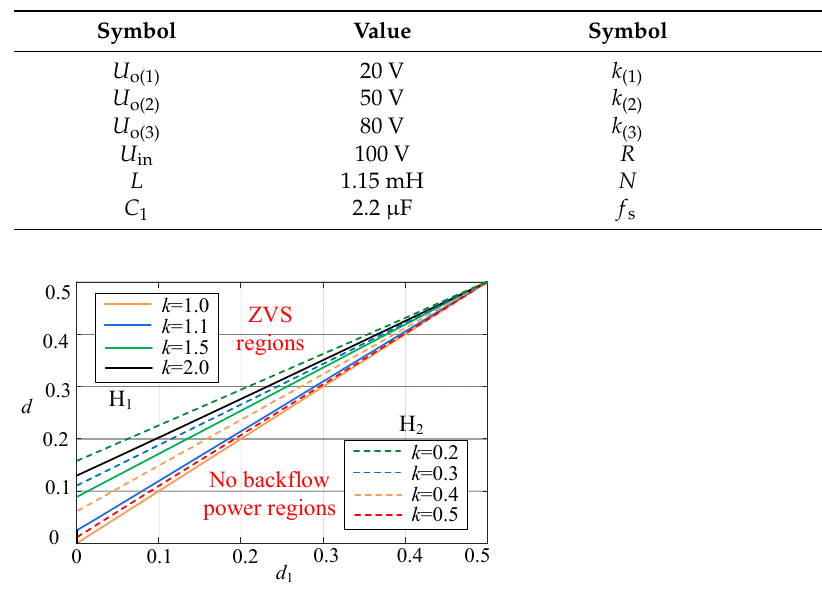
Table 1. Main system parameters.